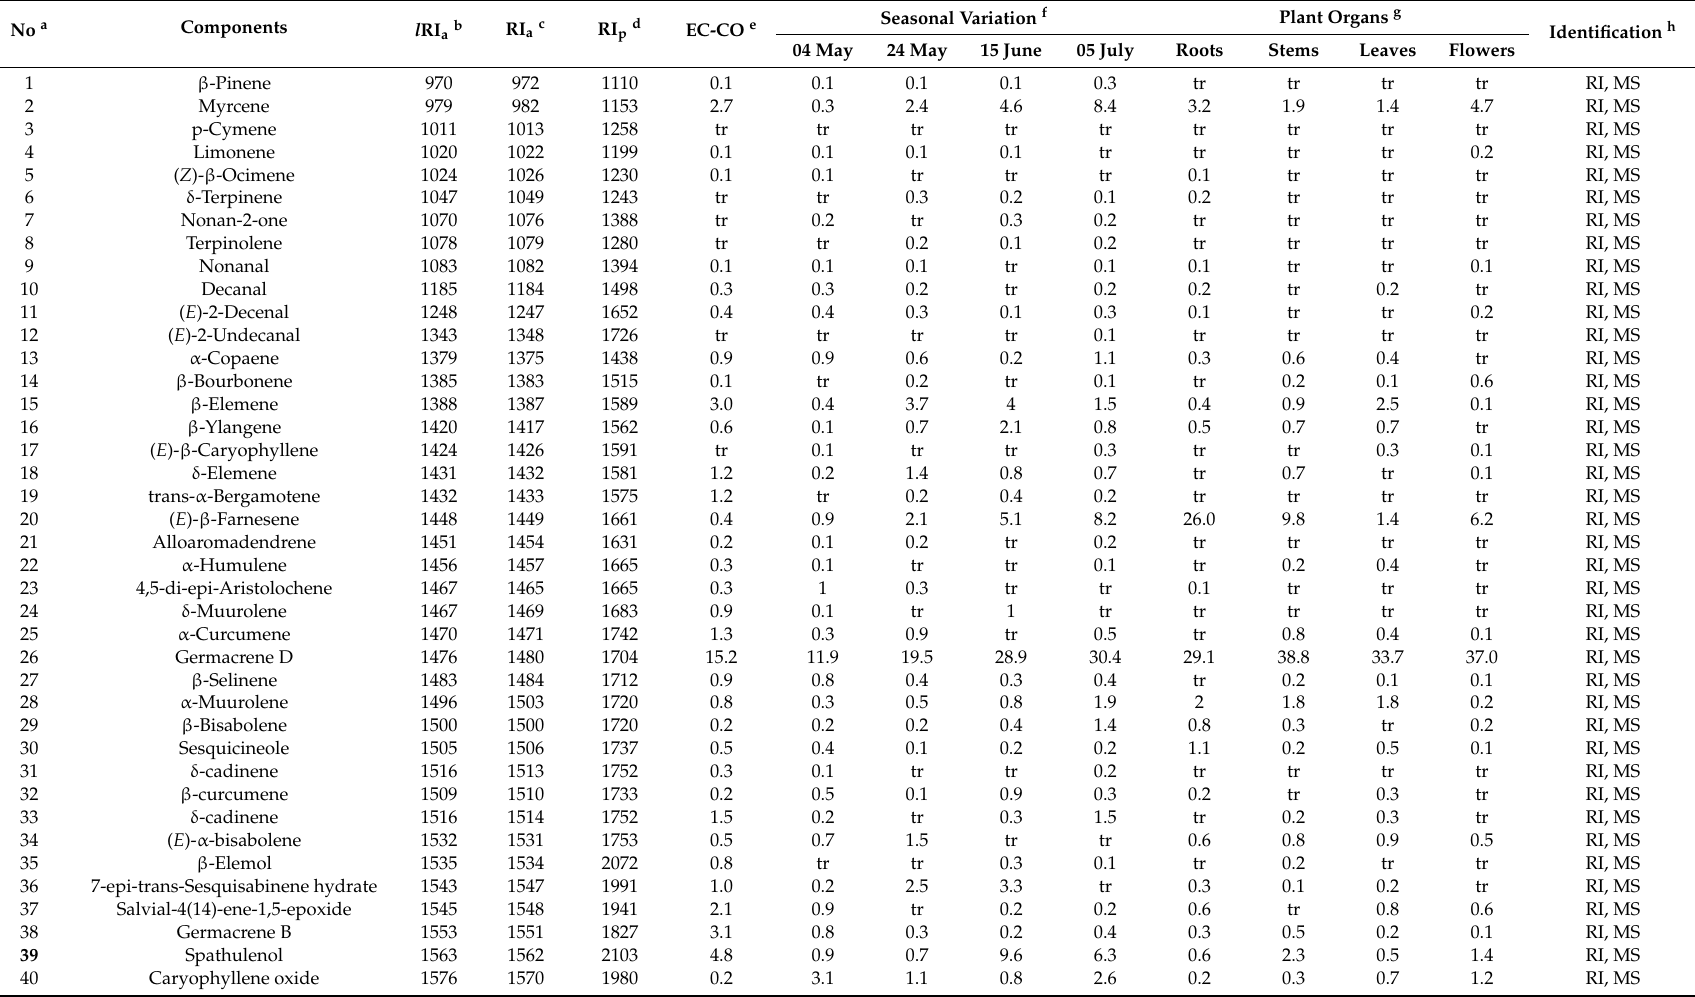
Table 3. Chemical composition of Eryngium campestre collective essential oil (EC-CO); —of essential-oils isolated from the aerial parts during the plant vegetative cycle (May–July) and —of essentials oils isolated from the di ff erent organs (flowers, leaves, stems, and roots) of sample